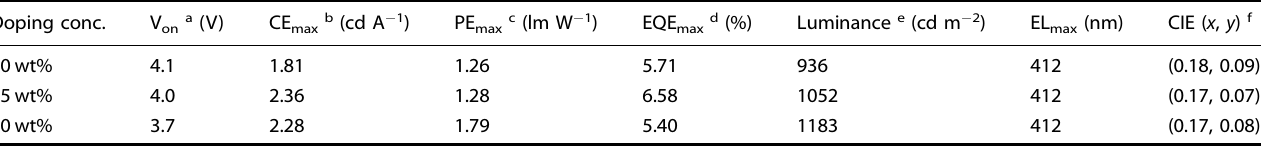
Table 2. EL performance of deep-blue OLEDs with TDBA-pyCz and DPAc-Cz. Doping